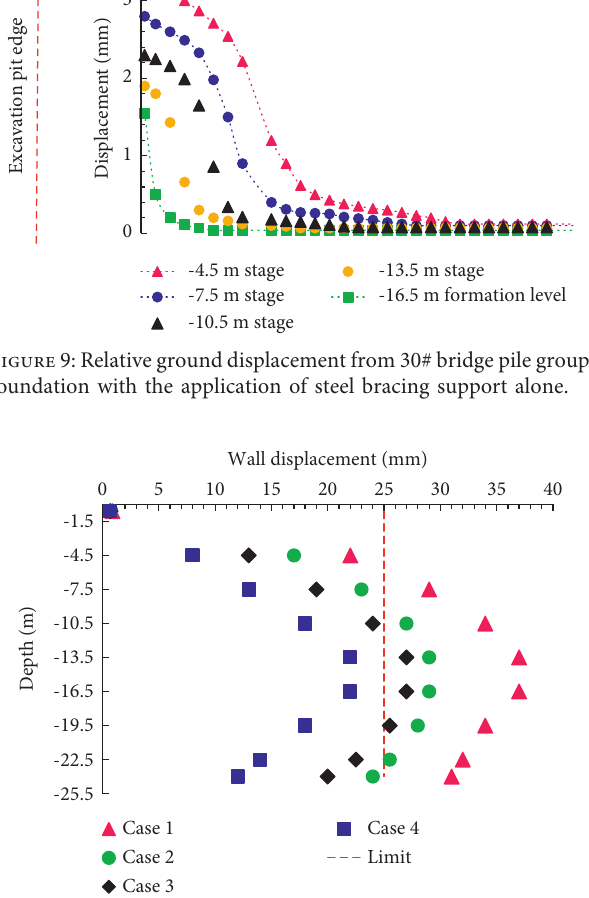
Figure 10: Influence of the application of steel bracing support with servo geotechnology axial loading capacity enhancement on wall lateral displacement profile in 4 case